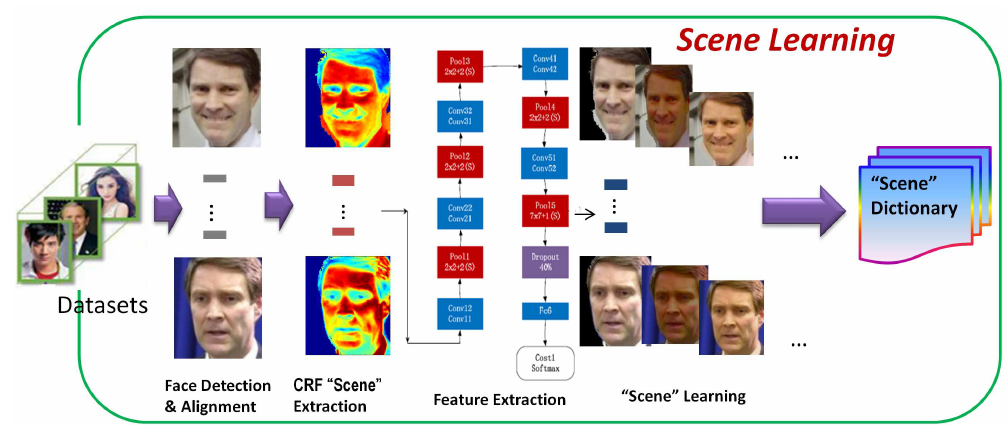
Figure 4. A pipeline for the proposed method.